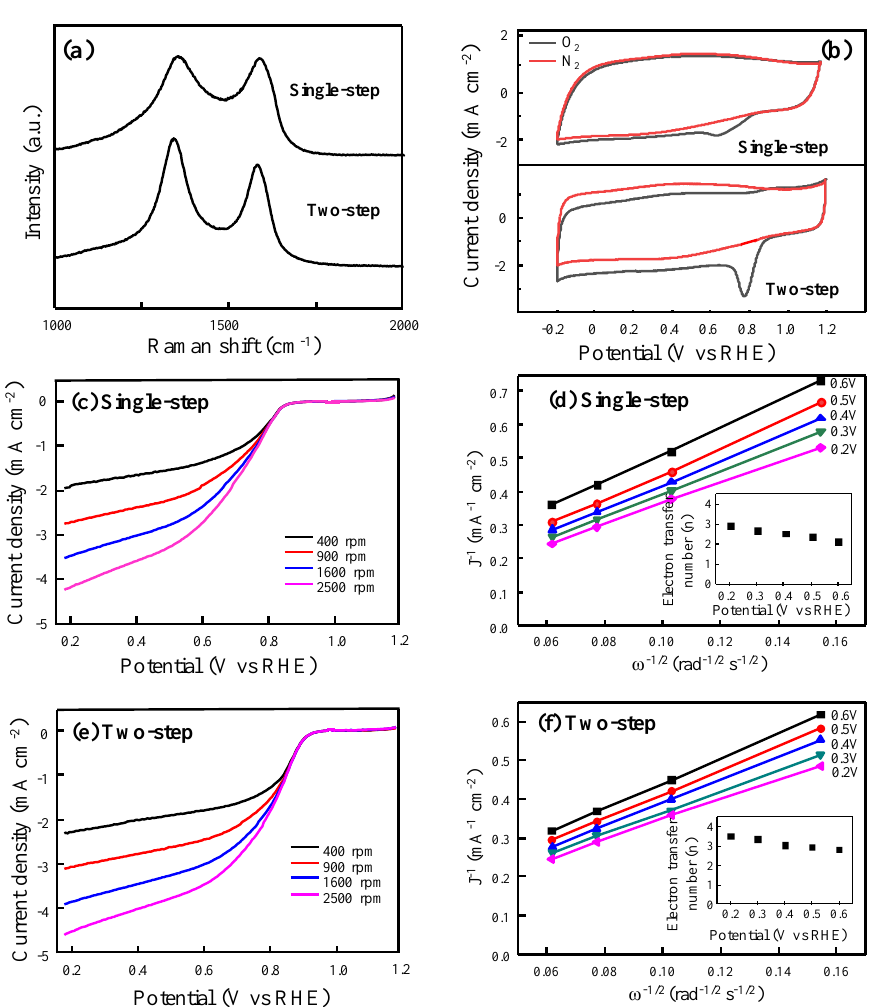
Figure 3. ( a ) Raman spectra and ( b ) cyclic voltammograms of ternary doped RGOs using single-step and two-step methods using a scan rate of 50 mV/s in N 2 or O 2 saturated 0.1 M KOH solution. Linear sweep voltammograms of ternary doped RGOs using ( c ) single-step and ( e ) two-step synthesis, obtained in a O 2 -saturated 0.1 M KOH aqueous electrolyte using different rotation speeds (scan rate of 5 mV/s) and ( d , f ) their K-L plots in the range from 0.2 to 0.6 V (inset is the electron transfer number at different potential).